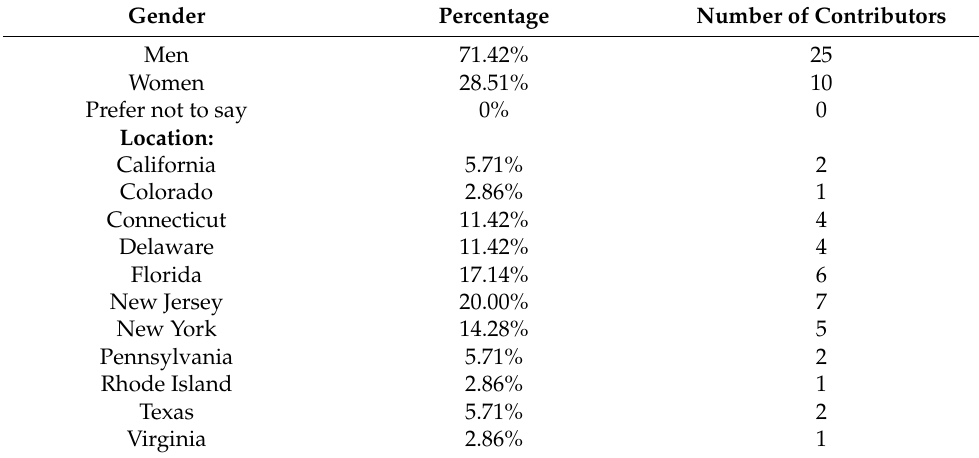
Table 2. Participant